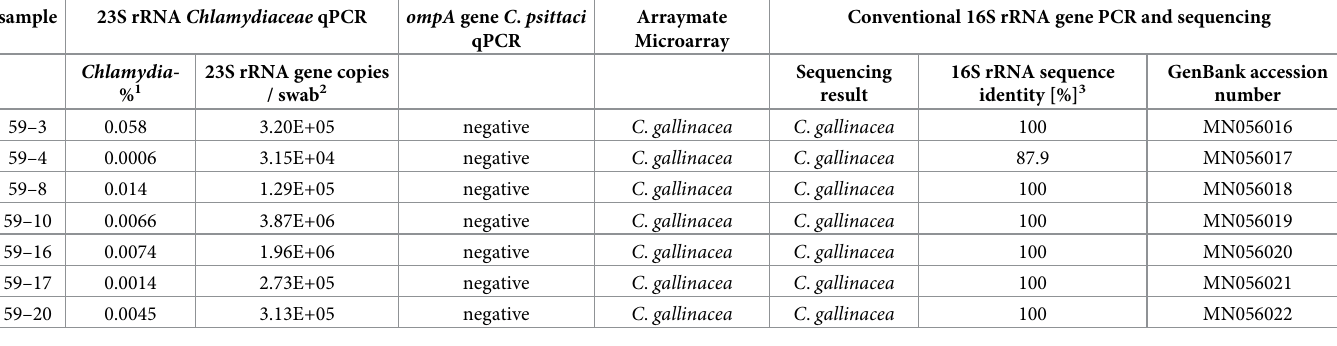
Table 2. 23S rRNA Chlamydiaceae qPCR-positive cloacal swab samples of turkeys at slaughter originating from flock 1 in farm